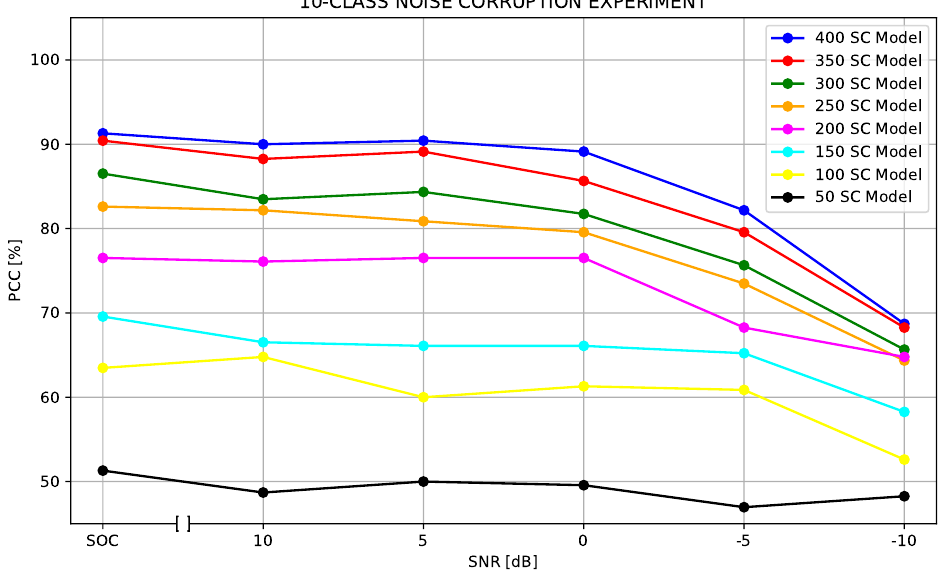
Figure 17. Classification results considering the addition of white Gaussian noise. The results were obtained for SNR = +10, +5, 0, − 5 and − 10